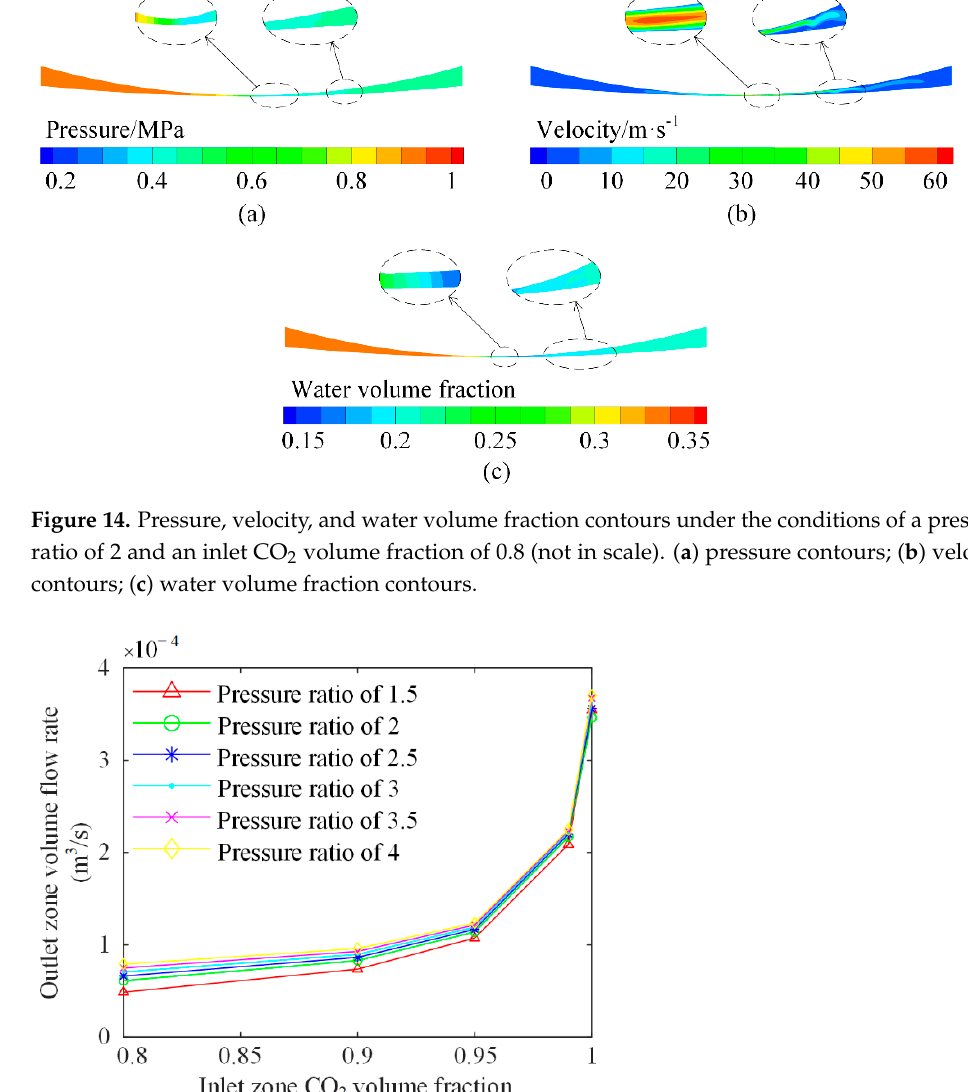
Figure 15. Leakage volume flow rates under different gas volume fractions and pressure